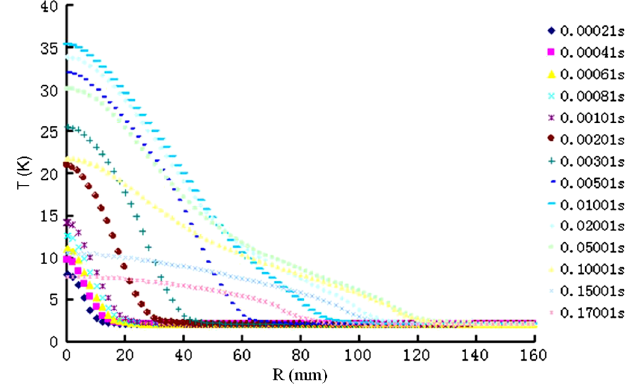
FIG. 9. Niobium surface temperature on the liquid helium side.